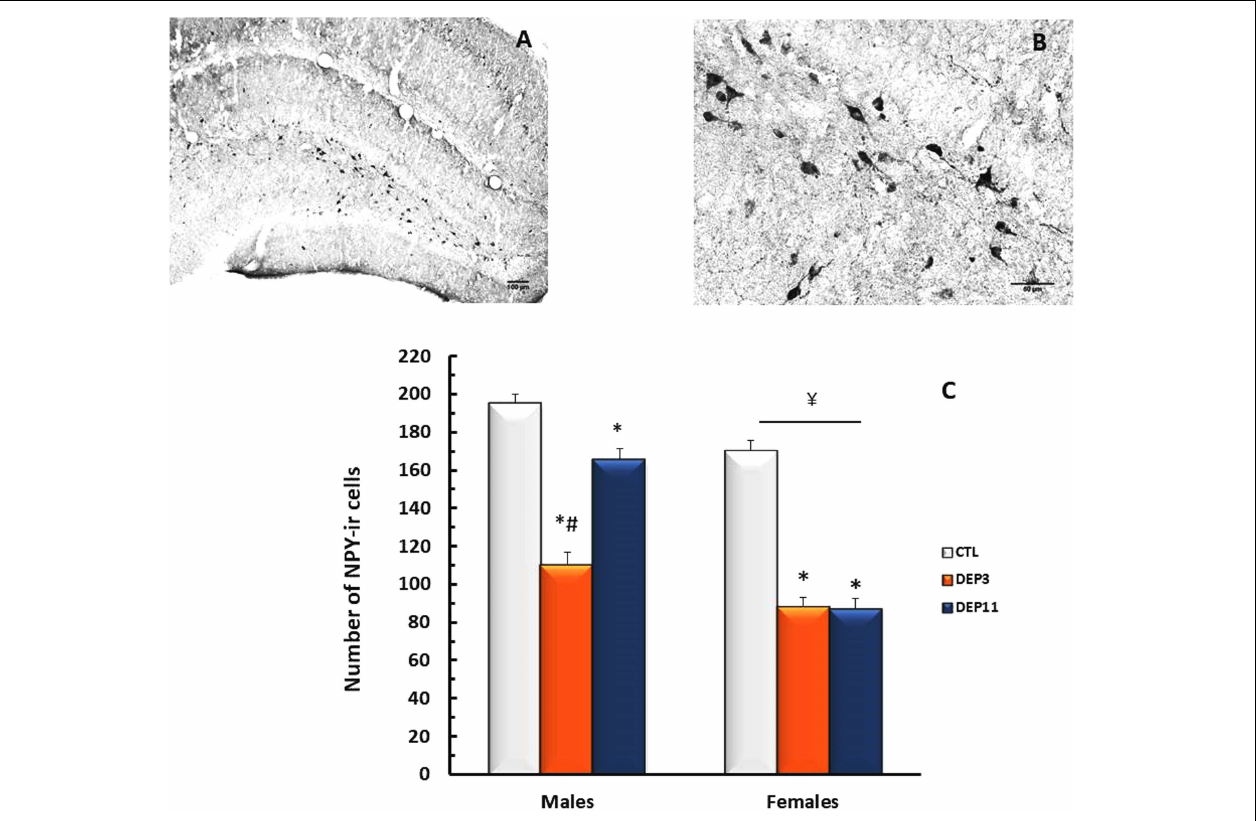
FIGURE 6 | Photomicrograph of the dorsal hippocampus (dHPC) of one control rat at 10x (A) and 40x magnification (B) . Number of NPY-immunoreactive neurons in the dHPC (C) of animals maintained with their mothers (CTL), deprived on postnatal day (PND) 3 (DEP3) or on PND 11 (DEP11) and perfused between PNDs 52 and 60. Data are presented as mean ± SEM of 11–15 males and 10–11 females/group. Scale bar in A = 100 µ m; scale bar in B = 50 µ m. ∗ – Different from CTL group; # – different from DEP11; (cid:85) – different from respective male